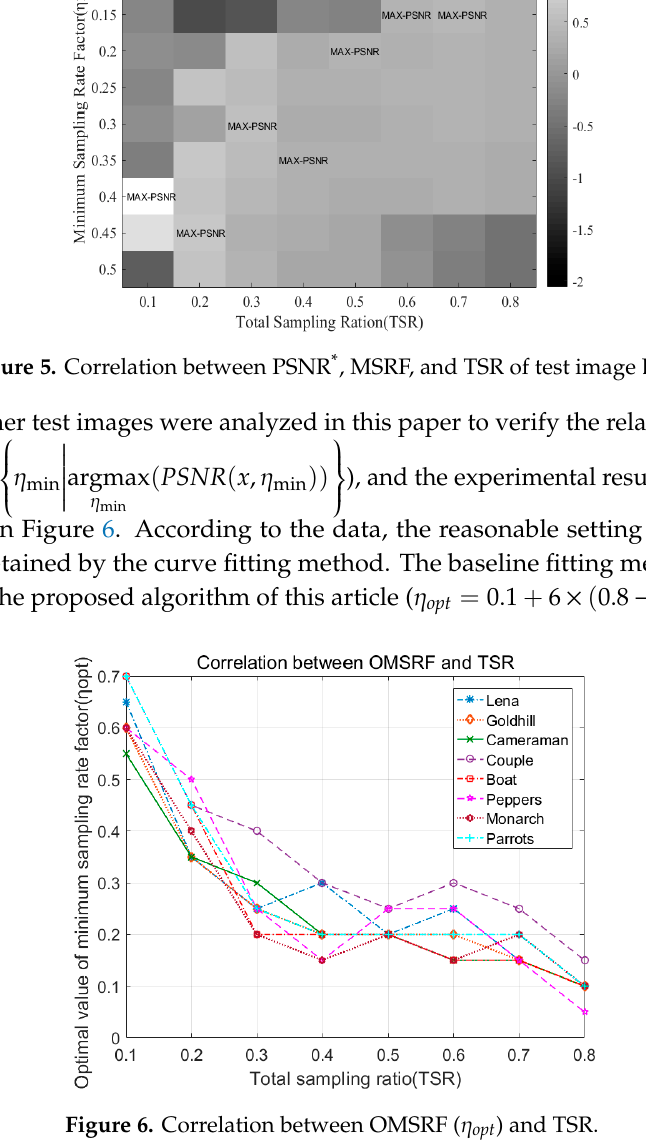
Figure 6. Correlation between OMSRF ( η opt ) and